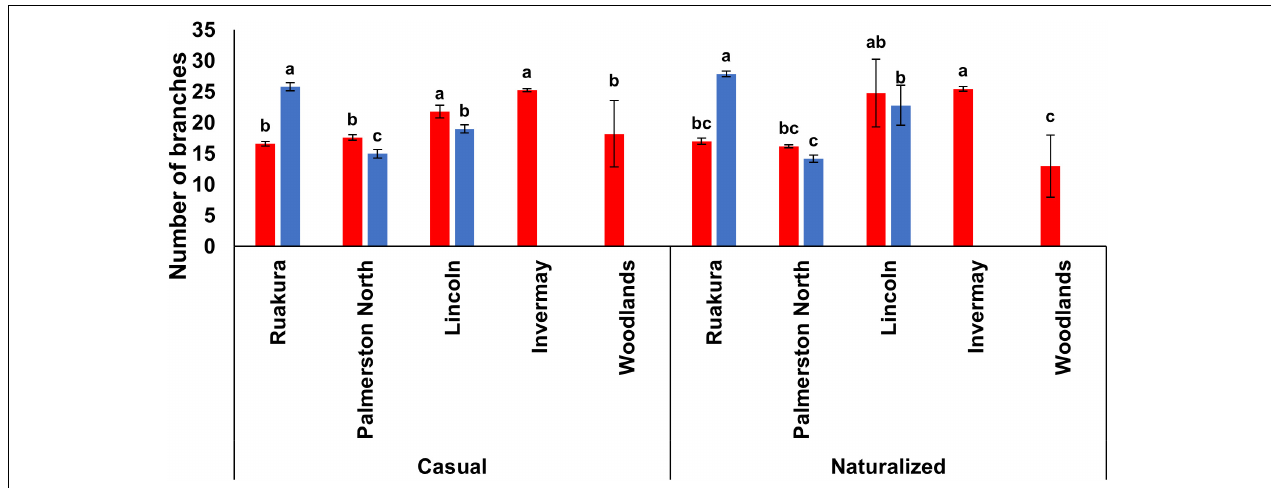
FIGURE 6 | The number of branches for the casual and naturalized populations of A. theophrasti in five different regions of New Zealand in the first (red bars) and second (blue bars) experiments. In the second experiment, plants in Woodlands died after emergence. For each population, vertical bars of the same colour with different letters are significantly different at 5% probability. The error bars represent ± standard error of the mean.